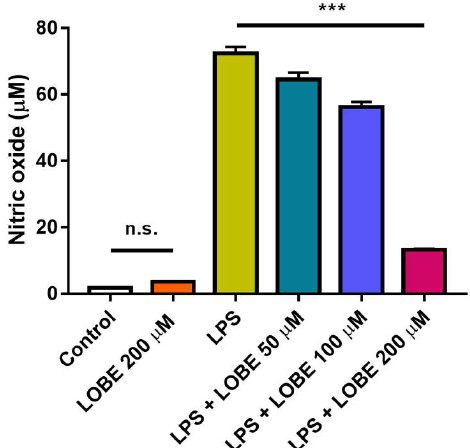
Figure 3. Inhibition of nitric oxide (NO) production by LOBE in lipopolysaccharide (LPS)-stimulated BMDMs. BMDMs were pre-treated with or without LOBE for 20 min, followed by stimulation or not with 0.1 µg/mL of LPS for 24 h. After 24 h, the NO-containing supernatant from each group was collected to quantify NO concentrations. Results are the mean ± SD of triplicate experiments: n.s, *** p < 0.001, significant difference as compared to the control group and each group by a one-way ANOVA followed by Tukey’s post hoc analysis.